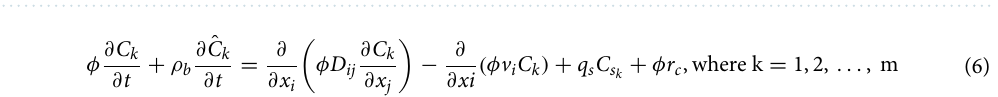
In Eq. 6, m is the total number of species, C k is the concentration of the k th species (M/L 3 ), t is time (T), D ij of aquifer representing sources and sinks (1/T), C s (M/L 3 ), ρ b is bulk density of porous media (M/L 3 ), r